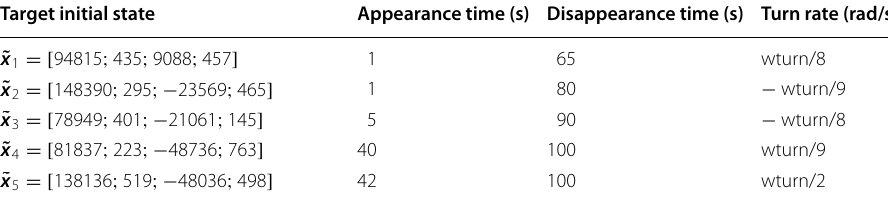
Table 2 The initial position of the targets Target initial